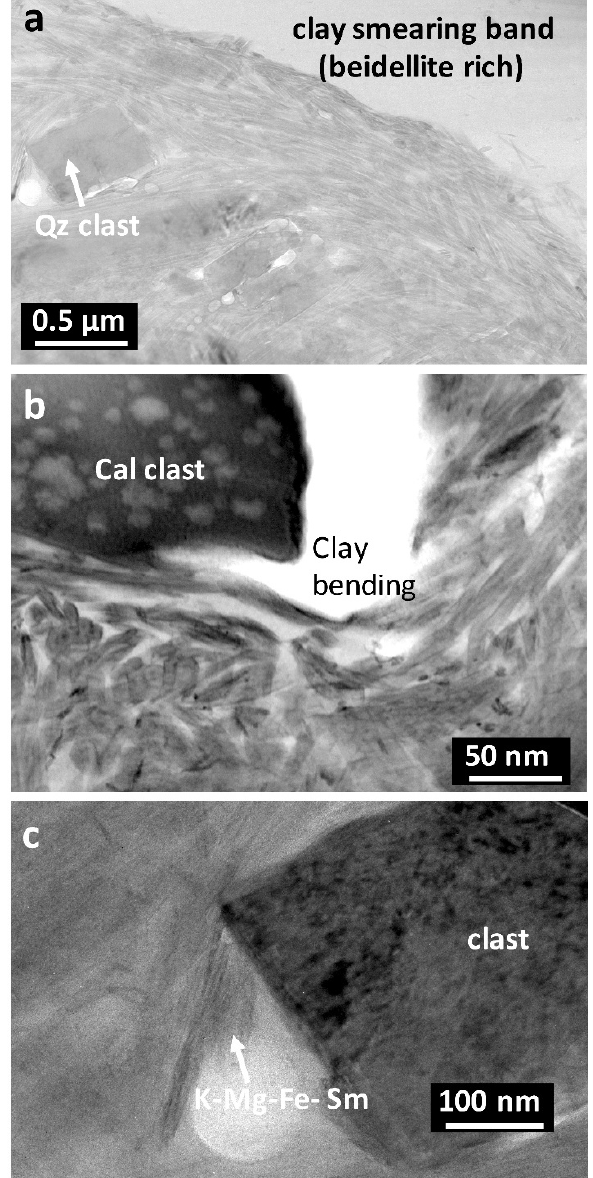
Figure 9. TEM images of the clay smearing bands. ( a ) Shear foliation defined by oriented beidellitic smectite. ( b ) Clast inside a clay smearing band enclosed by oriented phyllosilicates ( c ) Mg, Fe and K rich smectite in pressure shadow micropore. Cal: calcite, Qz: quartz.